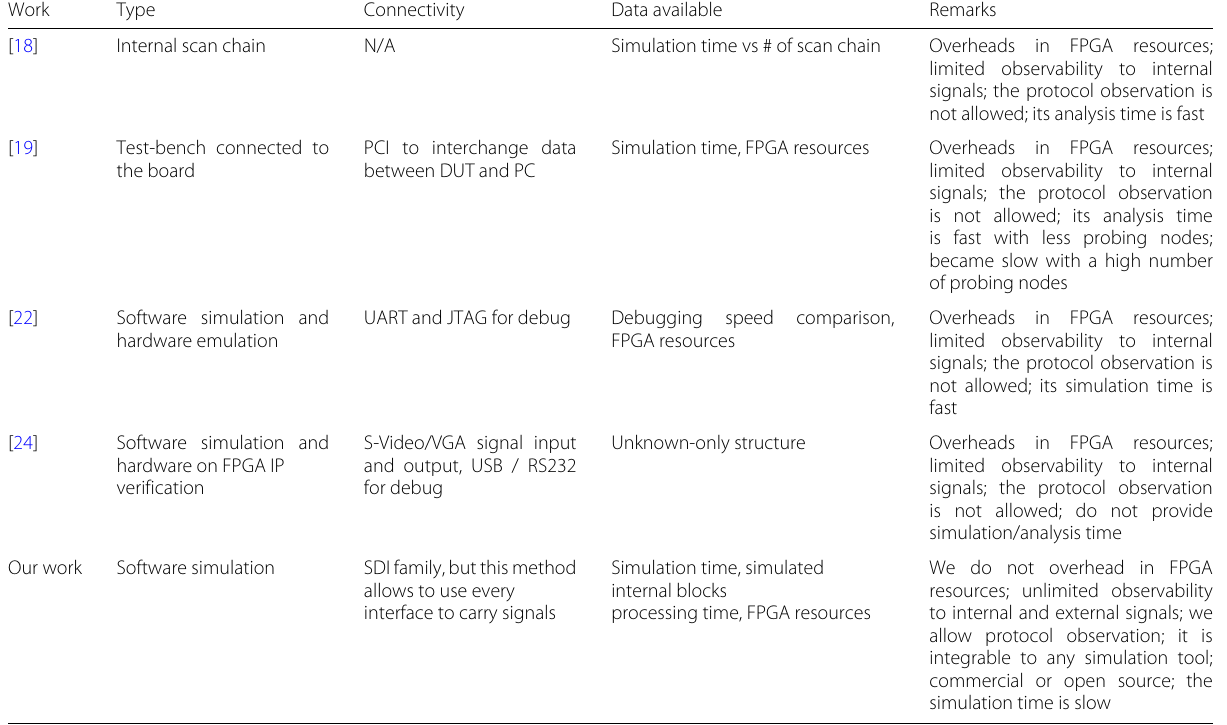
Table 1 Main characteristics of literature test-benches and differences with related work